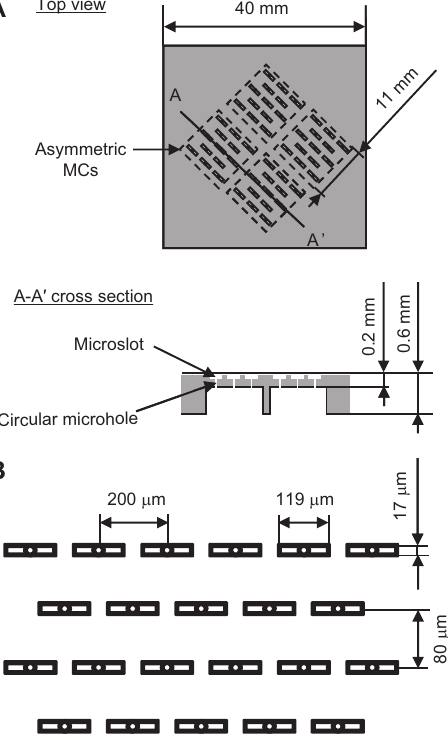
Figure 2 (A) Schematic representation of the WMS10 chip. (B) Sche- matic diagram of asymmetric MCs on the top side of the